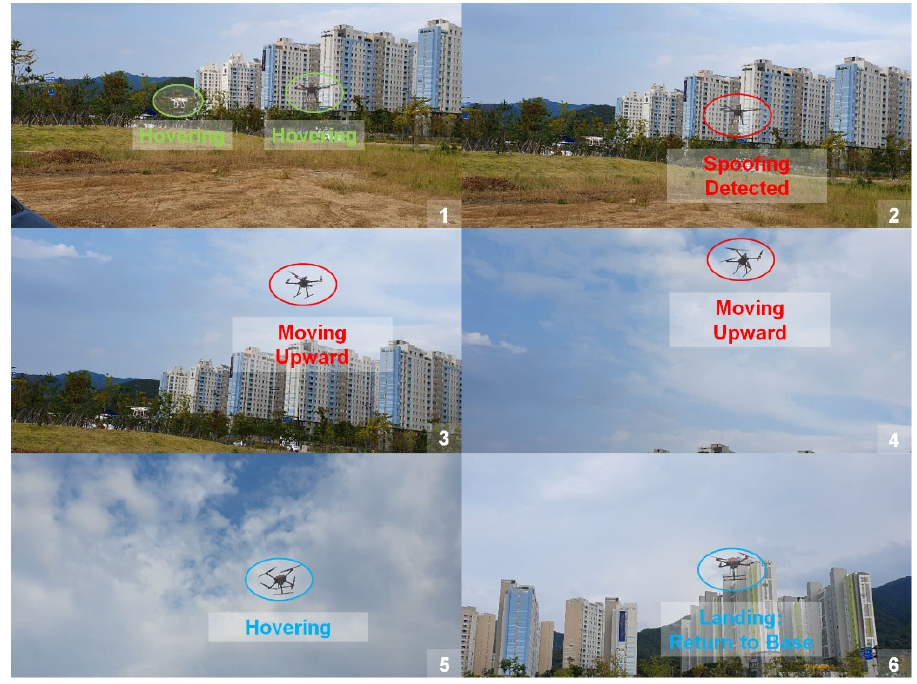
Figure 15. Spoofing detection and emergency landing of our drone in the flight test.